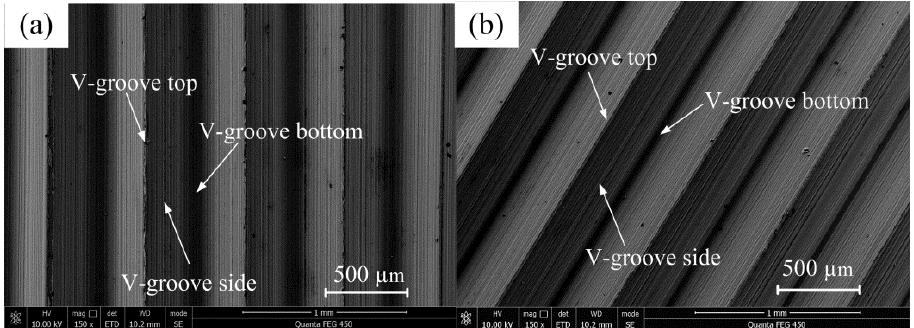
Figure 10. SEM photos of the micro-structured mold core under different orientations: ( a ) vertical; ( b ) inclined.